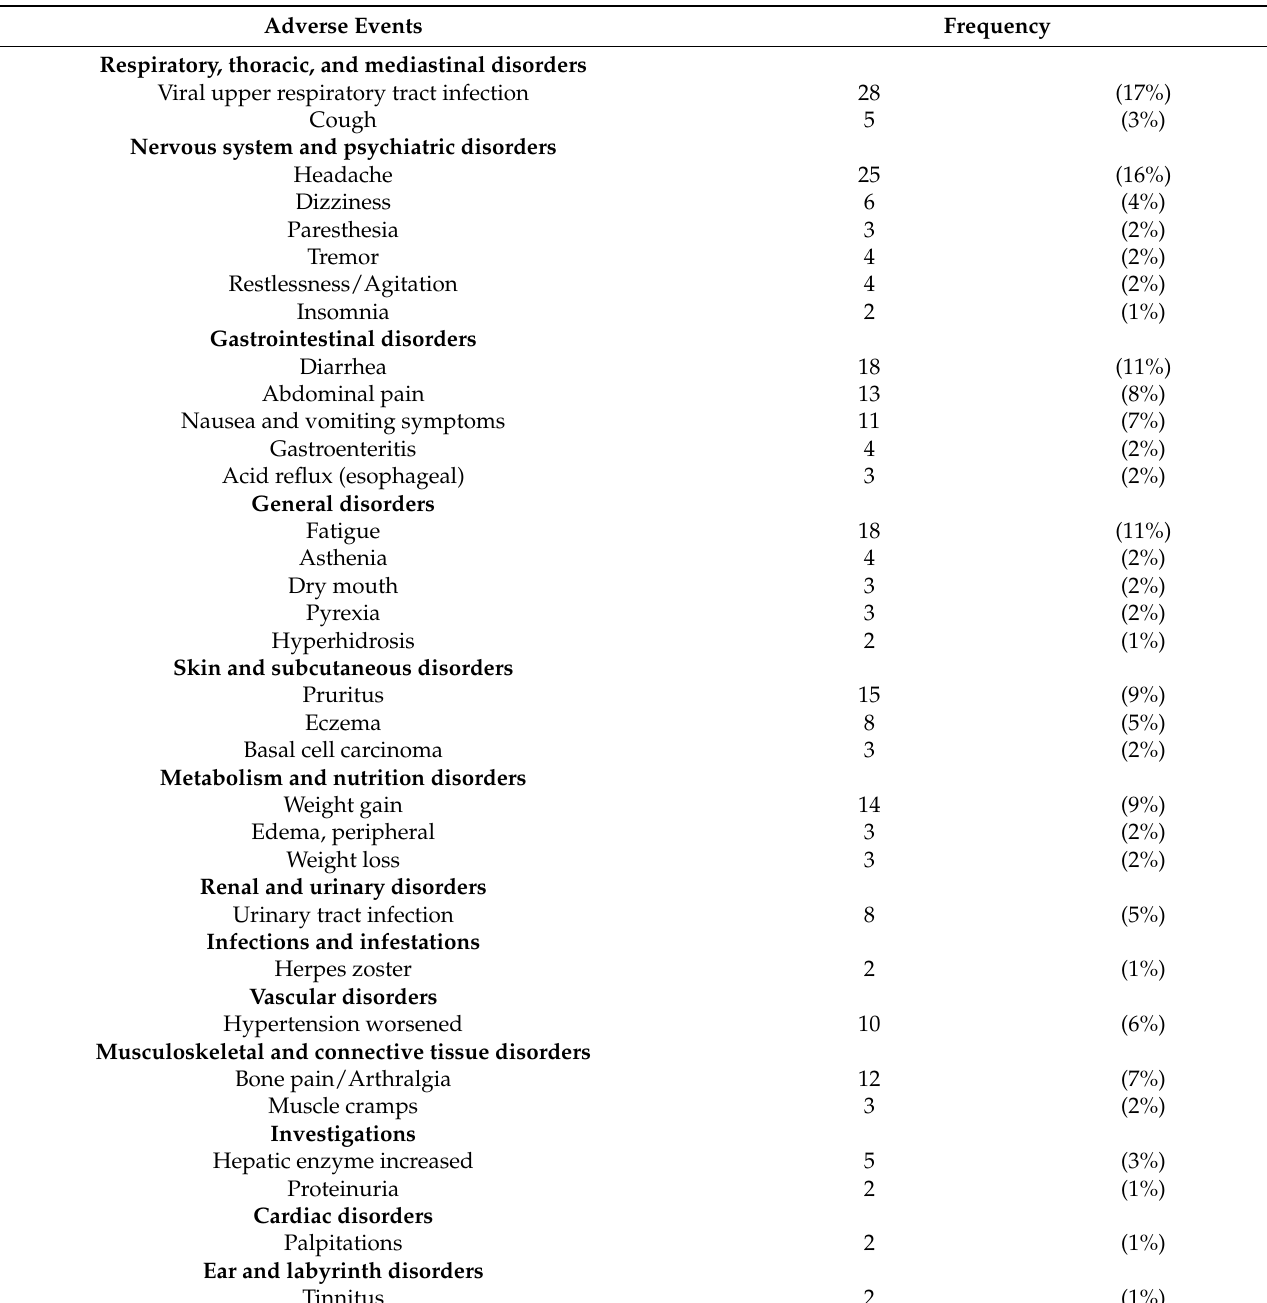
Table 5. Very common ( ≥ 10%) and common (1–10%) adverse events during the study period, N (% of patients). MedDRA (Medical Dictionary for Regulatory Activities) preferred